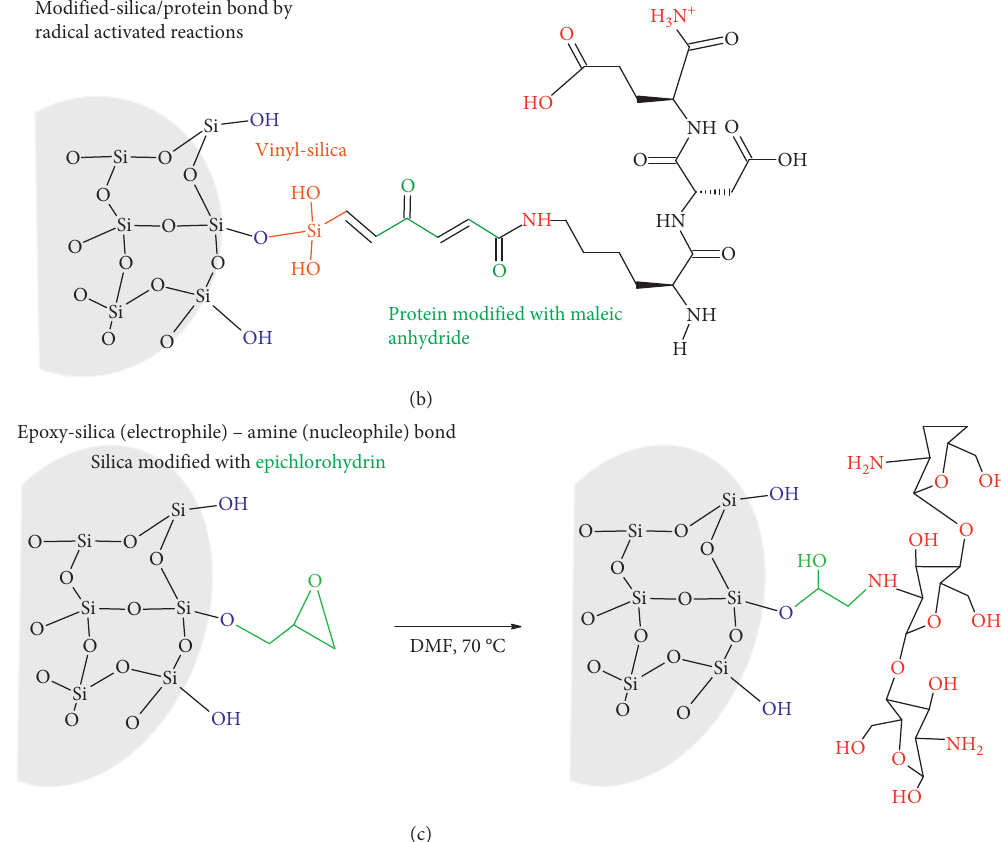
Figure 4: Chemical modification of silica and their contributions to their covalent bonding to proteins through (a) aminosilica-protein imine bonds mediated by bifunctional aldehyde crosslinkers (glyoxal; GA: glutaraldehyde; SQA: squarid acid); (b) radical activated reactions between vinyl-silica and maleic anhydride protein; (c) polysaccharide coupling via the epoxy opening in silica modified with epichlo- rohydrin at 70 ° C in dimethylformamide (DMF).